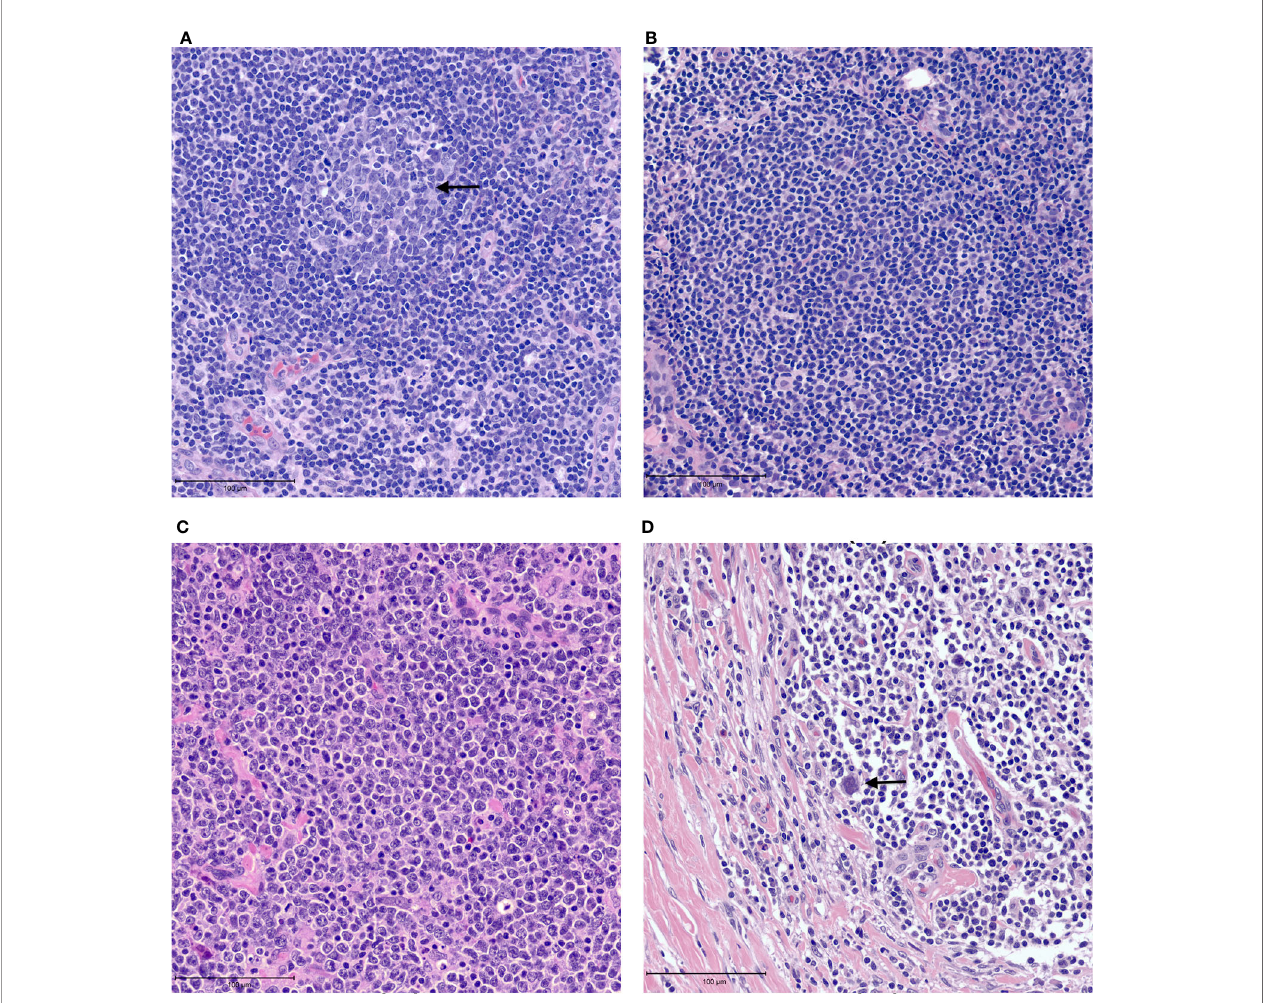
FIGURE 1 | Examples of tumor microenvironment in lymphomas. (A) Benign lymph node with a germinal center containing tangible body macrophages (arrow). (B) Follicular lymphoma with neoplastic follicle. (C) Diffuse large B cell lymphoma showing tissue effacement by large, neoplastic cells with very few admixed small lymphocytes. (D) Classic Hodgkin lymphoma showing rare Reed-Sternberg cells (arrow) in a background of small lymphocytes and histiocytes with fi